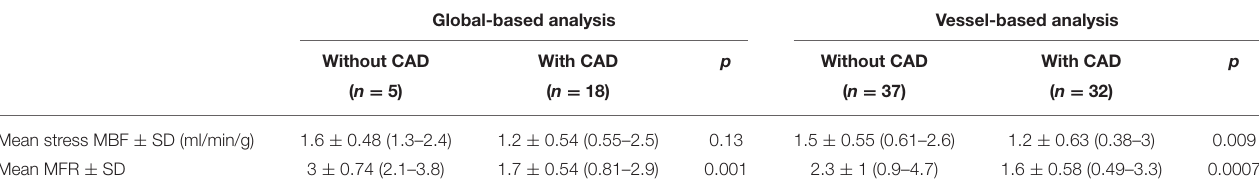
Mean stress MBF ± SD